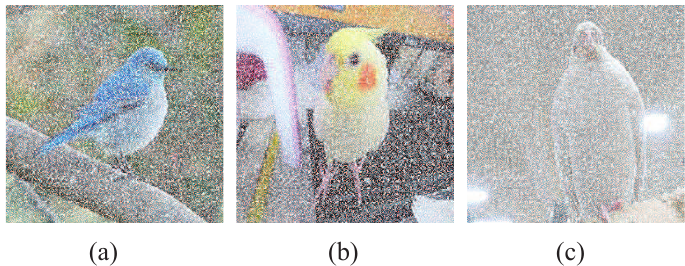
Figure 16. Color meaningful shadows of ( 3,3 ) -SDIS by the approach of enhancing visual quality: